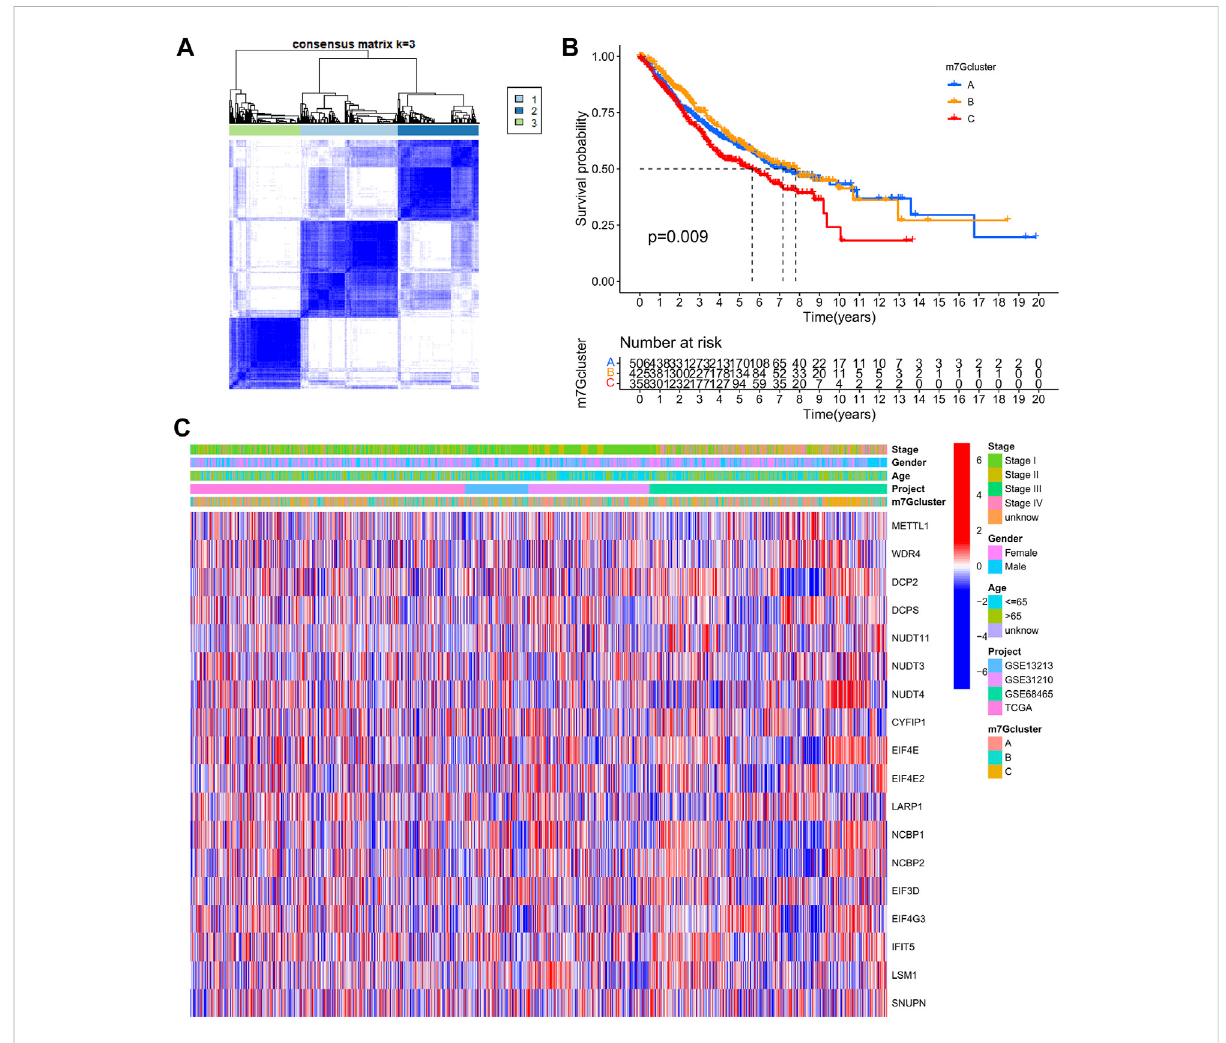
FIGURE 3 m7G-AssociatedLUADsubtypesandclinicalprognosis. (A) ConsensusclusteringwasusedtodividetheLUADpatientsinto3clusters( k =3). (B) Kaplan – Meier OS curves of the 3 LUAD m7G-Clusters. (C) Clinical pathological features of the 3 LUAD